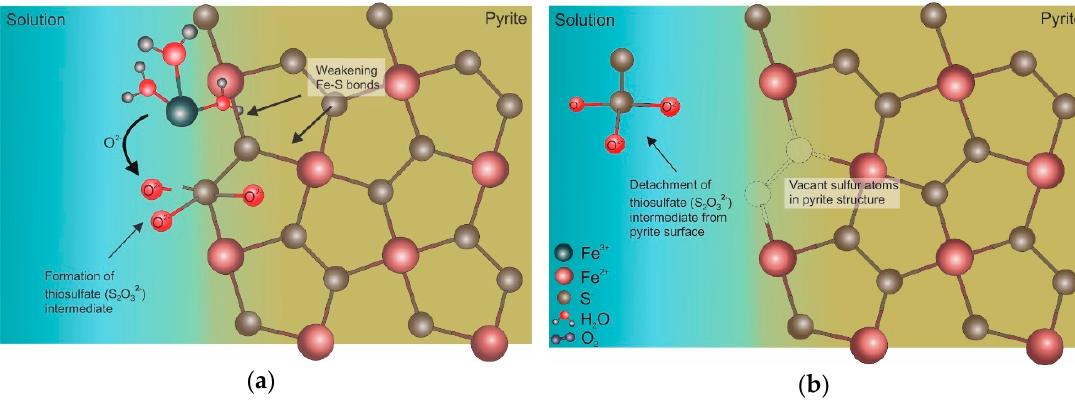
Figure 4. Illustration of the formation of sulfur oxyanion during the abiotic oxidation of pyrite using the example of thiosulfate. ( a ) Addition of oxygen molecules from the aqueous Fe 3+ (H 2 O) 6 complex to pyrite sulfur to form thiosulfate. ( b ) The oxygen transfer continues until the detachment of the stable thiosulfate.